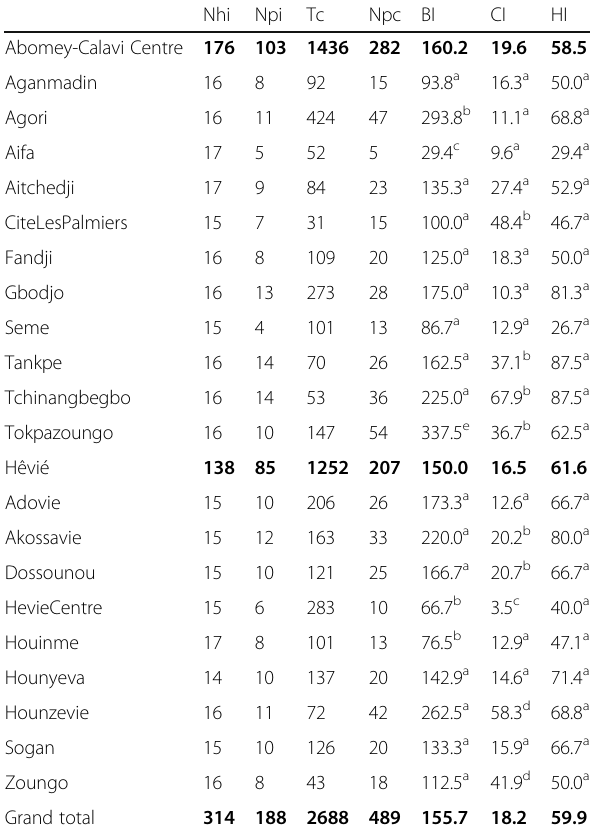
Table 1 Breteau, Container, and House indices in Abomey- Calavi Centre and Hêvié